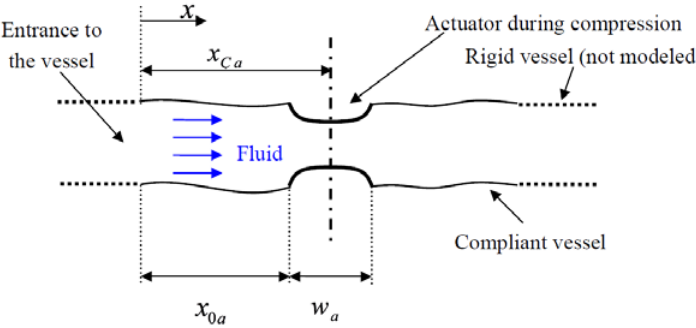
Figure 2. A sketch of a compliant vessel with an actuator and the notations used.